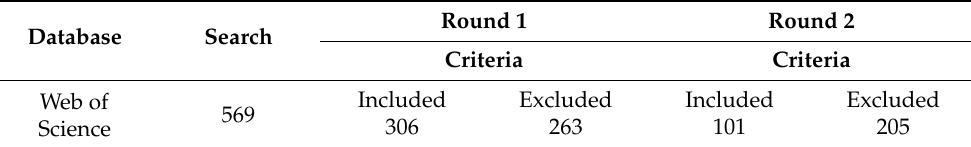
Table 1. Number of selected articles according to the inclusion/exclusion criteria.